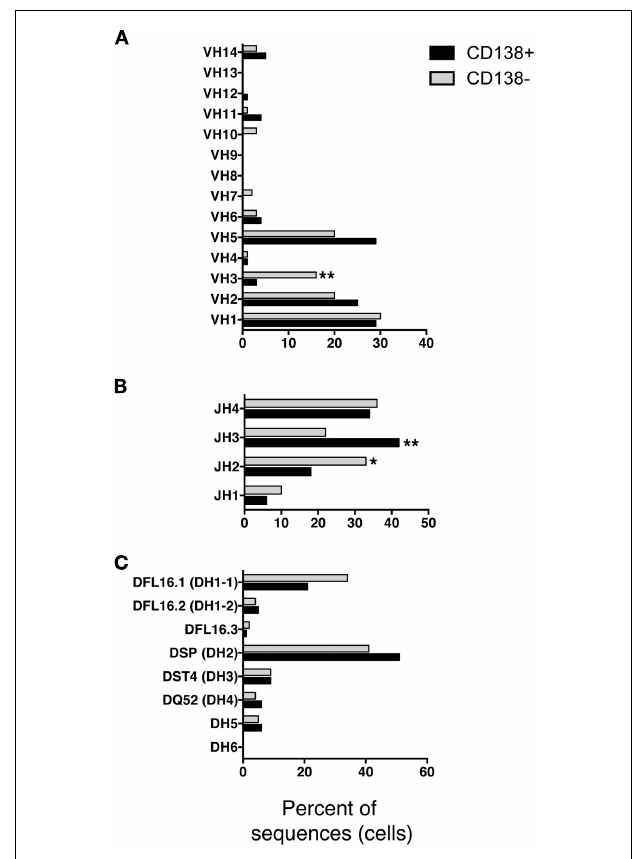
FIGURE 3 |VH, DH, and JH analysis of CD138 + and CD138 − splenic B-1a cells. Immunoglobulins were amplified by PCR from single sorted splenic CD138 + ( n = 77) and CD138 − ( n = 92) B-1a cells and evaluated for (A) V, (B) J, and (C) D segment heavy chain usage.The percent of cells (sequences) expressing each segment is displayed. Chi square and Fisher’s exact tests were used to determine